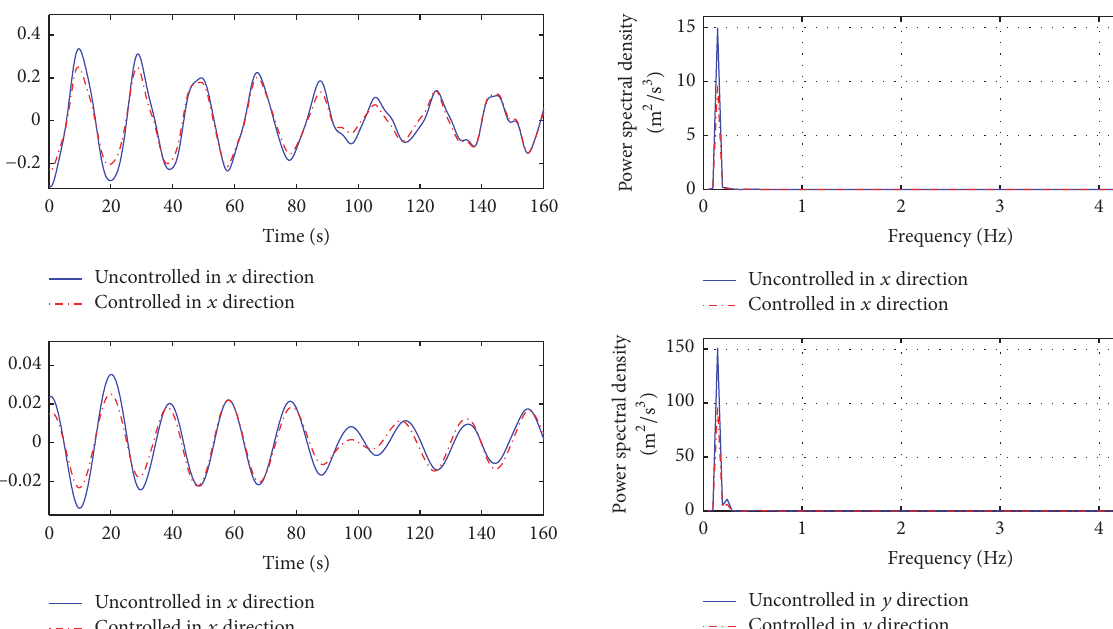
Figure 9: Power spectral density of acceleration responses.